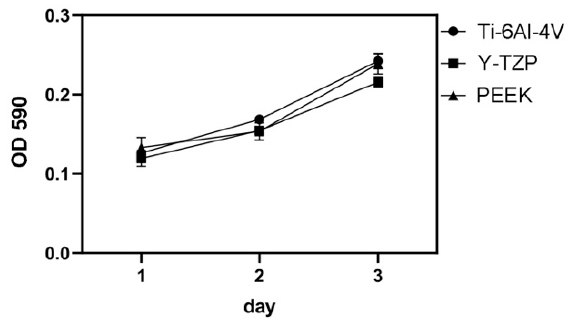
Figure 7. The results of cell viability (MTT